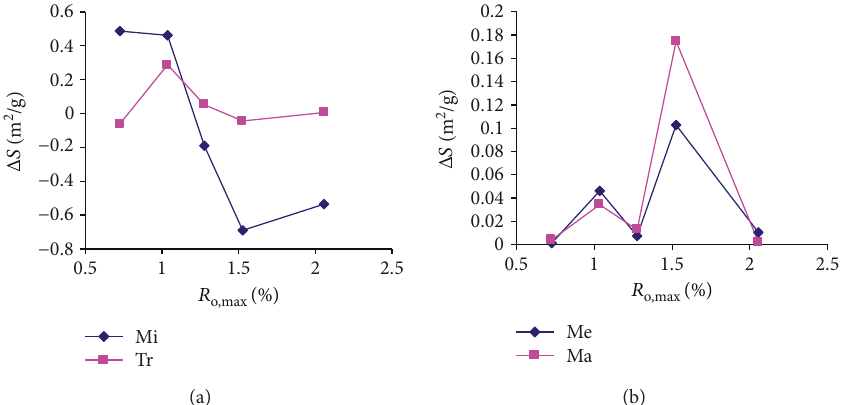
Figure 4: Plots of the changes in SSA with coal rank: (a) SSA change in micropore and transitional pore and (b) SSA change in mesopore and